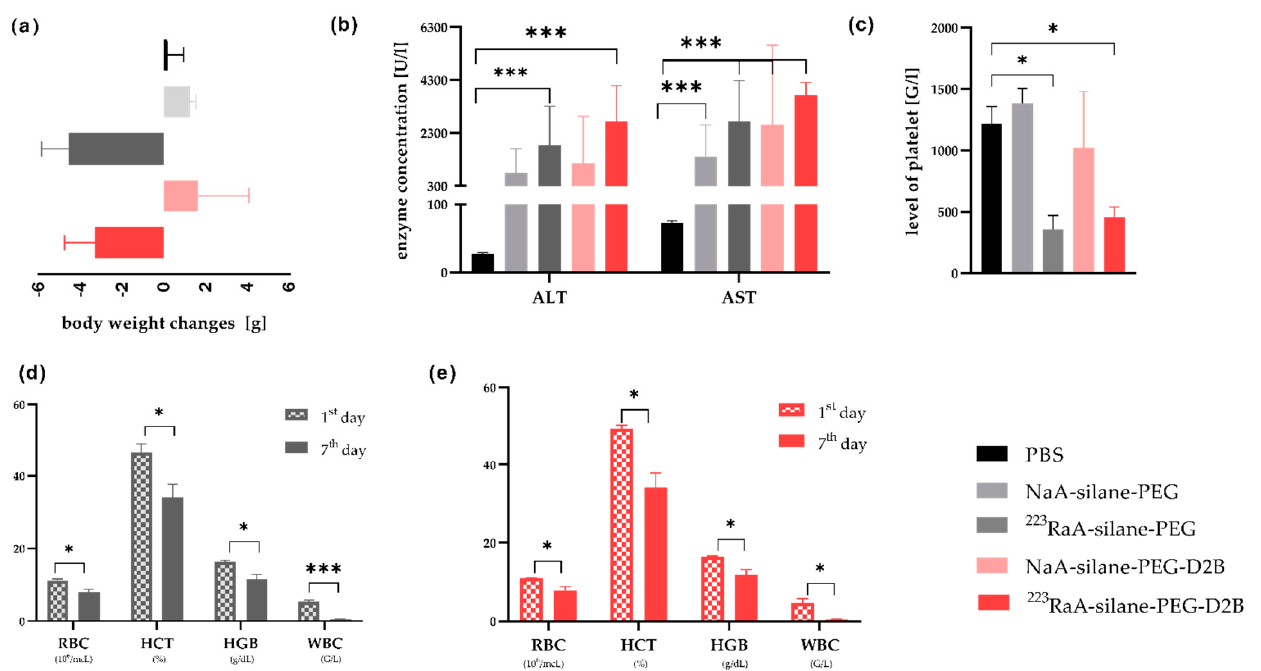
Figure 7. Influence of unlabeled and radiolabeled compounds on hematological and biochemical parameters of blood and body weight 7 days after a single injection of the tested compounds in BALB/c mice. Body weight ( a ), concentration of ALT and AST enzymes ( b ), concentration of platelets ( c ), hematological parameters in blood of mice exposed to NaA-silane-PEG ( d ) and NaA-silane-PEG-D2B ( e ). Data are expressed as the mean ± standard deviation (SD) from 10 mice/group. * p < 0.05, ** p < 0.01, *** p < 0.001 versus control group. The mean value of RBC (red blood cell) counts never decreased below the lower ref- erence limit (6.93 × 10 3 mcL) [23], but 7 days after injection, the concentration of platelets